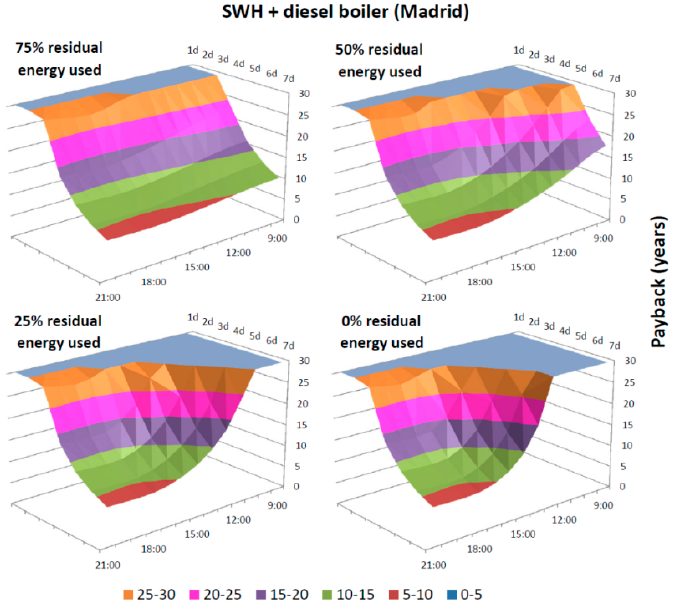
Figure 7. SWH profitability (updated payback) in a facility with diesel boiler, for different scenarios of residual energy available the next day.